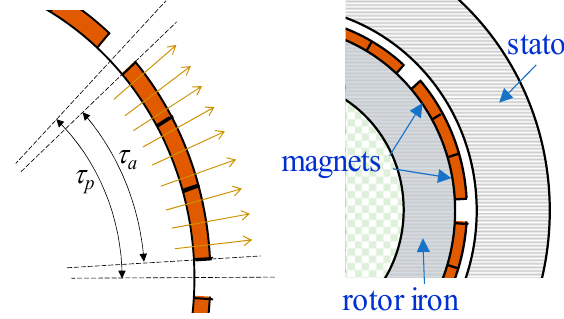
Figure 6. One pole pitch of the considered motor.